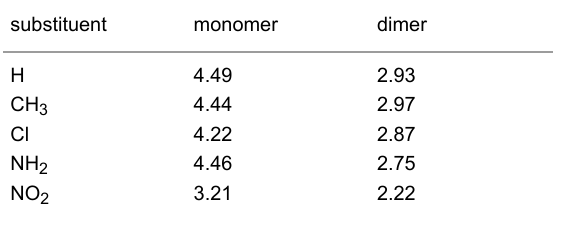
Structural effects concerning bond lengths in the monomers and dimers compared to the unsubstituted Tp and BTp turned out to be negligibly small. Nevertheless, the dihedral angle between the two aromatic ring-systems in the substituted dimers differs from BTp. Except for the chlorine-substituted dimer (ClBTp), all BTp derivatives show dihedral angles of about 22 ° to 24 ° .